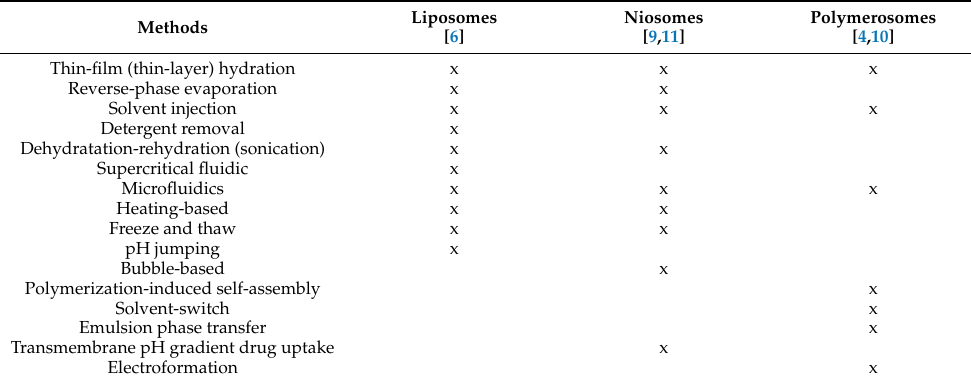
Table 1. Selection of main vesicle preparation